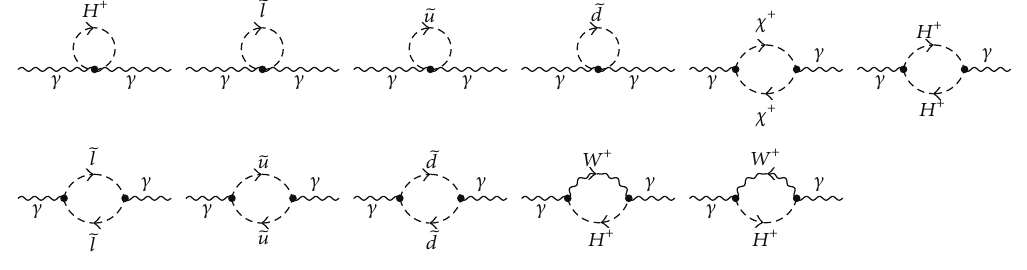
Figure 6: Feynman diagram contribution to the self-energy Π NMSSM 𝛾𝛾 (𝑠) .